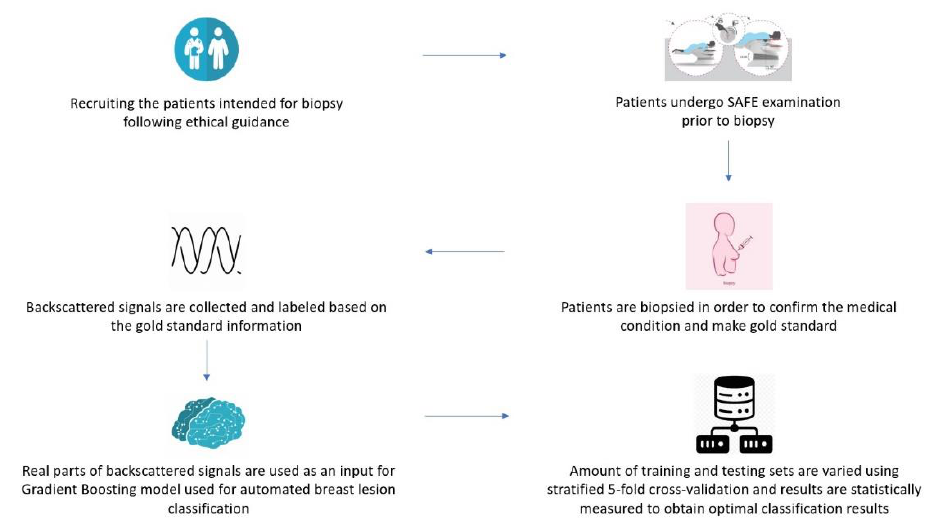
Figure 2. Flowchart of the proposed approach for MBI automated breast lesion classification.